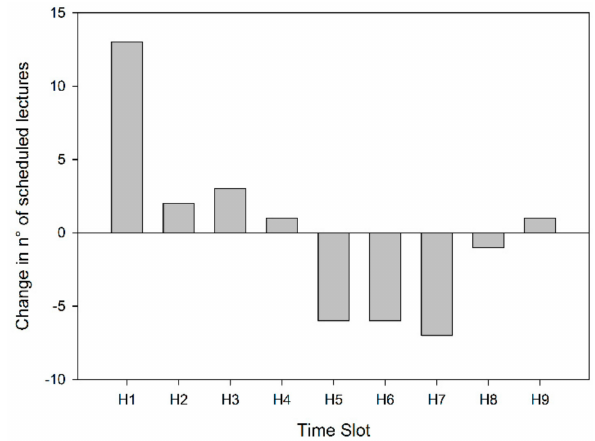
Figure 2. An increase in the lectures scheduled in the morning time slots was observed using the model.